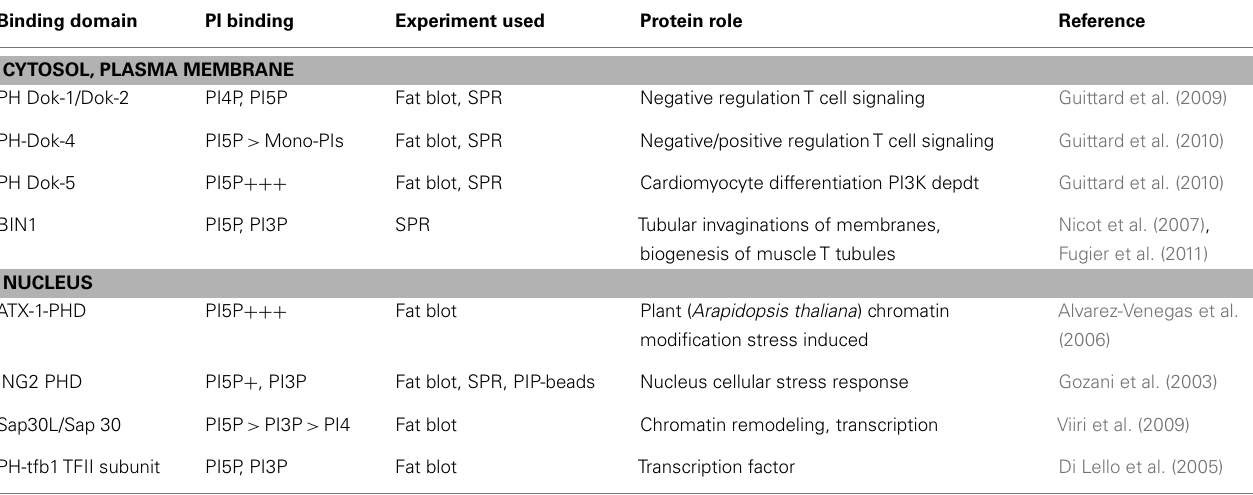
Table 2 | Some cellular proteins containing a lipid/protein interaction domain were identified as PI5P binding